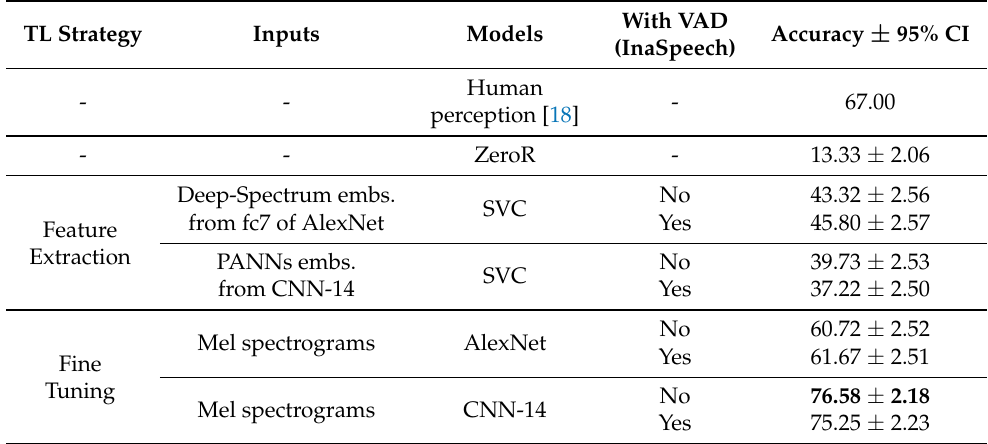
Table 1. Quantitative evaluation of the different strategies on speech emotion recognition. In bold, the best model.